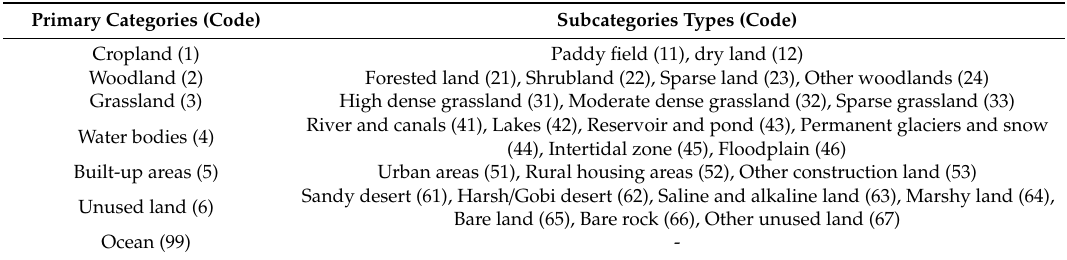
Table 1. The initial classification of Land use/land cover data.